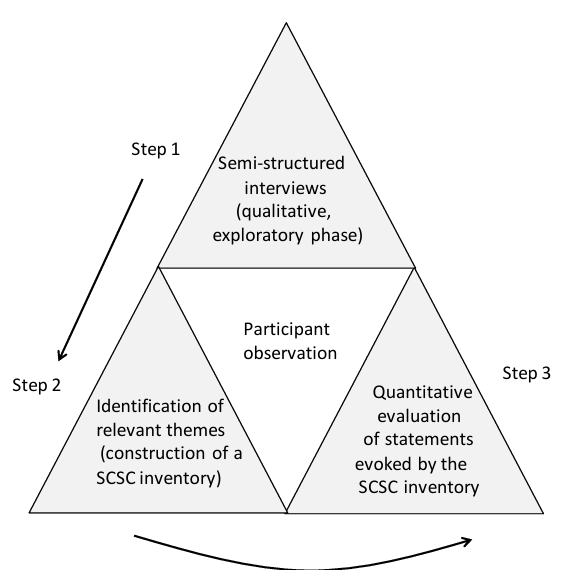
Figure 1. Summary of the qualitative and quantitative triangula- tion method used to evaluate the students’ concepts of science and common sense. Step 1 , This is an exploratory phase based on semi-structured interviews to explore the concepts of the MD- PhD students. Step 2 , The interviews were subjected to content analysis to identify the most relevant themes for construction of a